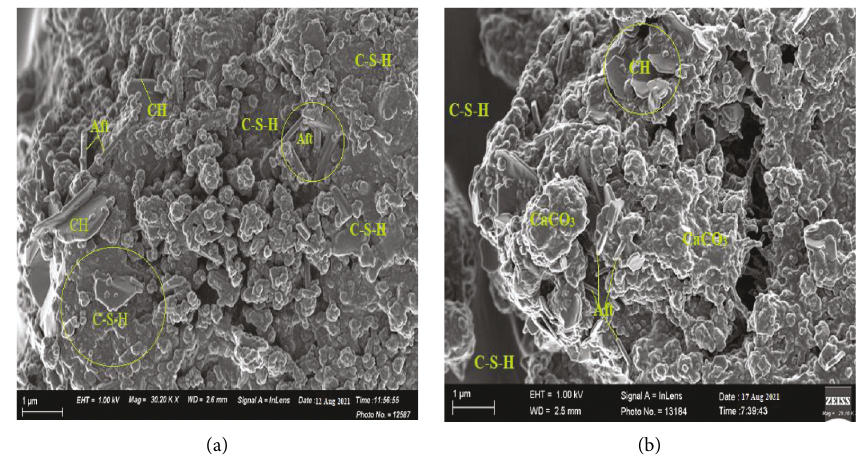
Figure 2: PPC cured with distilled water (a) and PPC cured with L ysinibacillus sphaericus bacteria solution